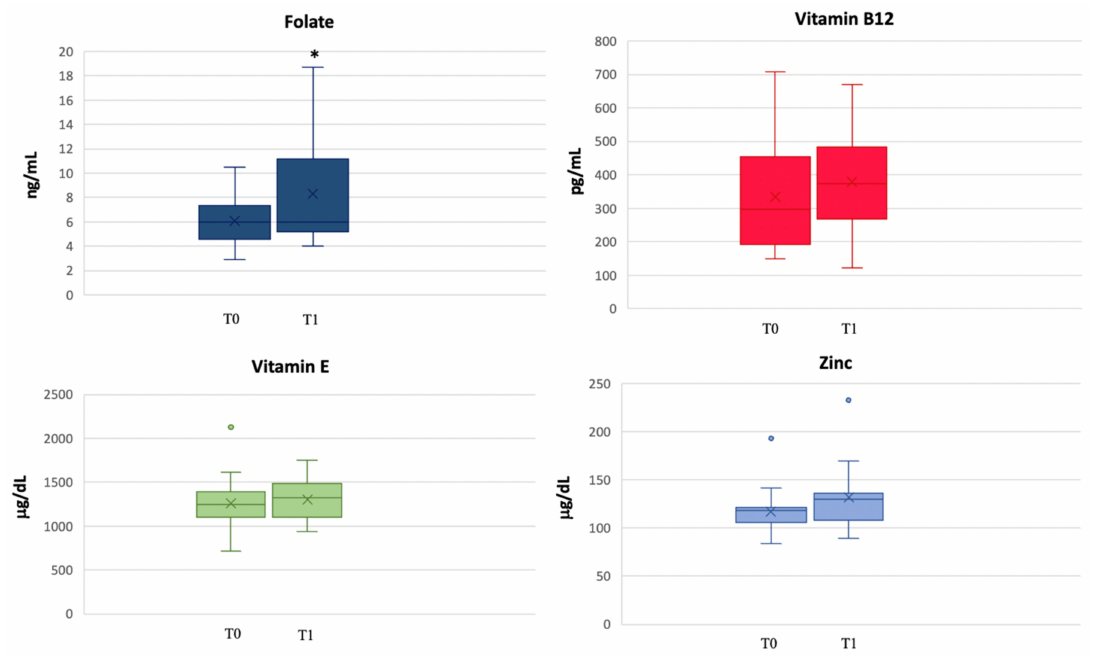
Figure 2. Changes in folate, vitamin B12, vitamin E and zinc concentrations from T0 to T1. * p < 0.05. A reduction in homocysteine levels from T0 to T1 (9 µ mol/L vs. 7.9 µ mol/L, p = 0.01), probably due to an improvement in vitamins regulating its metabolism (folate, B12 vitamin, and B6 vitamin), was found (Figure 3). Indeed, two out of three patients with homocysteine levels above 13 µ mol/L, had normalised their levels at T1. In just one patient, the level of homocysteine was slightly beyond the range of normality.